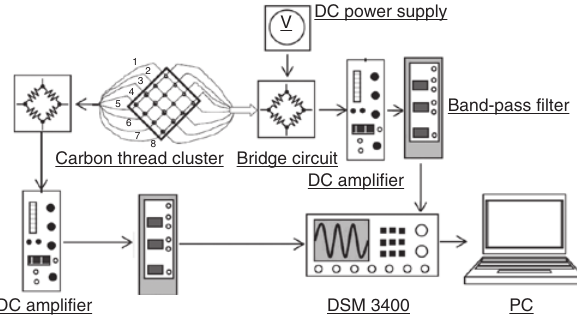
Figure 3: Schematic illustration of the experimental setup for dynamic measurements.